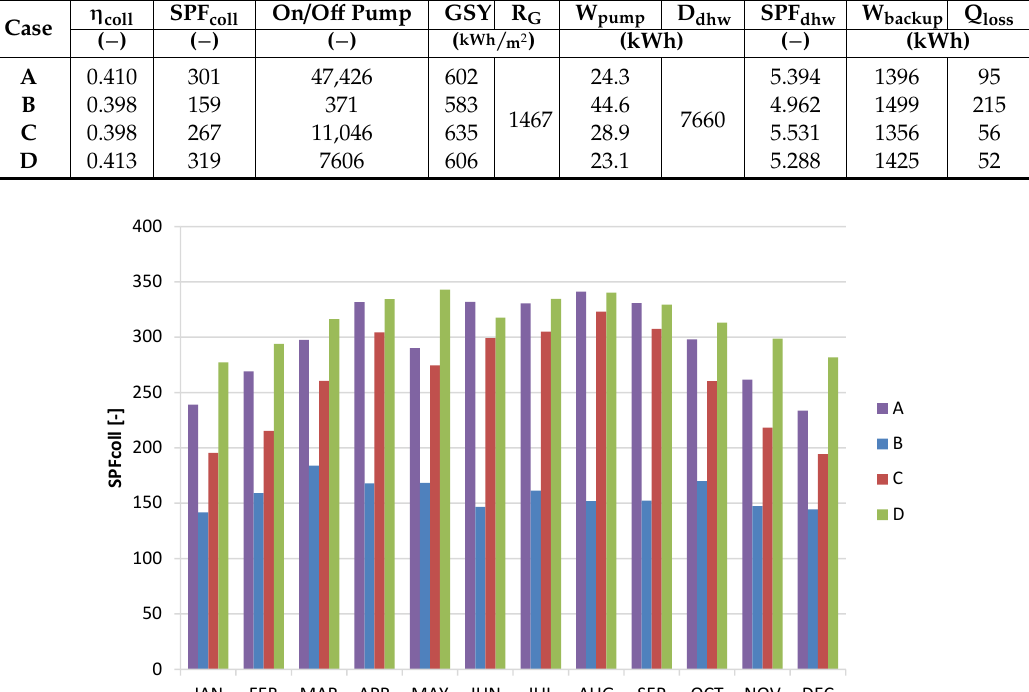
Figure 7. Monthly profile of the solar pump on/off cycles between the four different control strategies. 3.2. Fuzzy Logic Controller The development of a fuzzy–based reinforcing learning algorithm was seen as a way to attain good performance both in terms of SPF and in terms of on/off cycles. Reducing on/off cycles to a minimum can have a great impact on the expected life of circulators, increasing it significantly. The fuzzy controller was designed starting from the logic of case B where the independent quantity was the solar irradiance and the control variable the circulator speed. As mentioned in Section 2.3, the linguistic terms “low”, “medium”, and “high” were implemented with three triangular membership functions centred at about 0, 600, and 1200 W/m 2 , respectively. The output membership functions were defined in the same way, with three triangular membership functions,